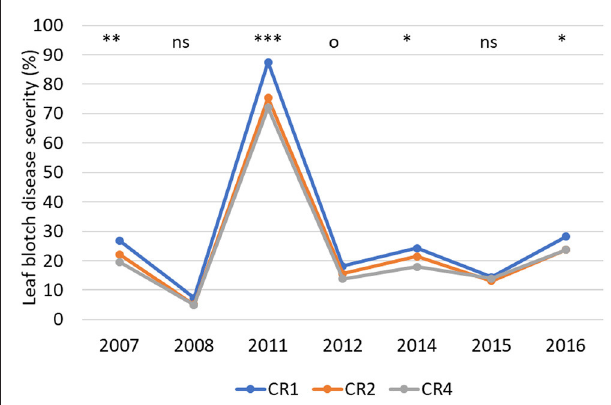
FIGURE 5 | The average leaf blotch disease severity (%) in spring wheat in different years and crop rotations. CR1, wheat monoculture; CR2, wheat every 2nd year; CR4, wheat every 4th year. Statistically significant differences: ns = not significant, o p < 0.10, * p < 0.05, ** p < 0.01, *** p <